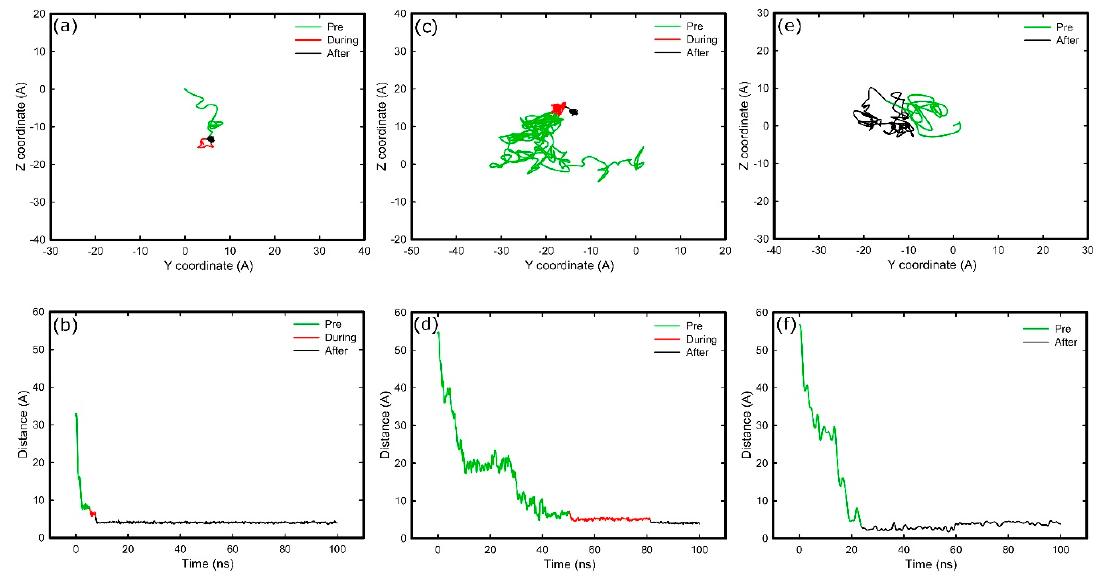
Figure 4. Diffusion of residues over the surface (top), and distance of residues perpendicular to the surface over time (bottom) for; anchoring residue of FNIII 8 in amine system (Glu1312) ( a , b ), anchoring residue of FNIII 10 in amine system (Thr1509) ( c , d ); and anchoring residue of FNIII 10 in silica system (Thr1509) ( e , f ). Green, red, and black respectively illustrate the trajectories before, during, and after anchoring.